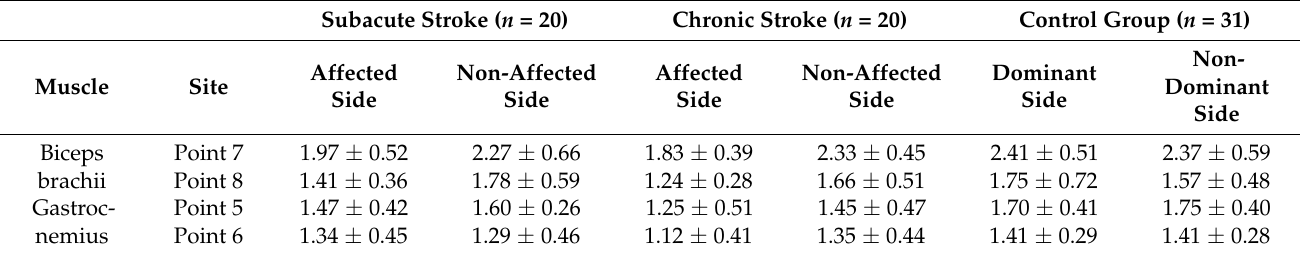
Table 4. Muscle thickness (cm) of the biceps brachii and gastrocnemius muscles in stroke